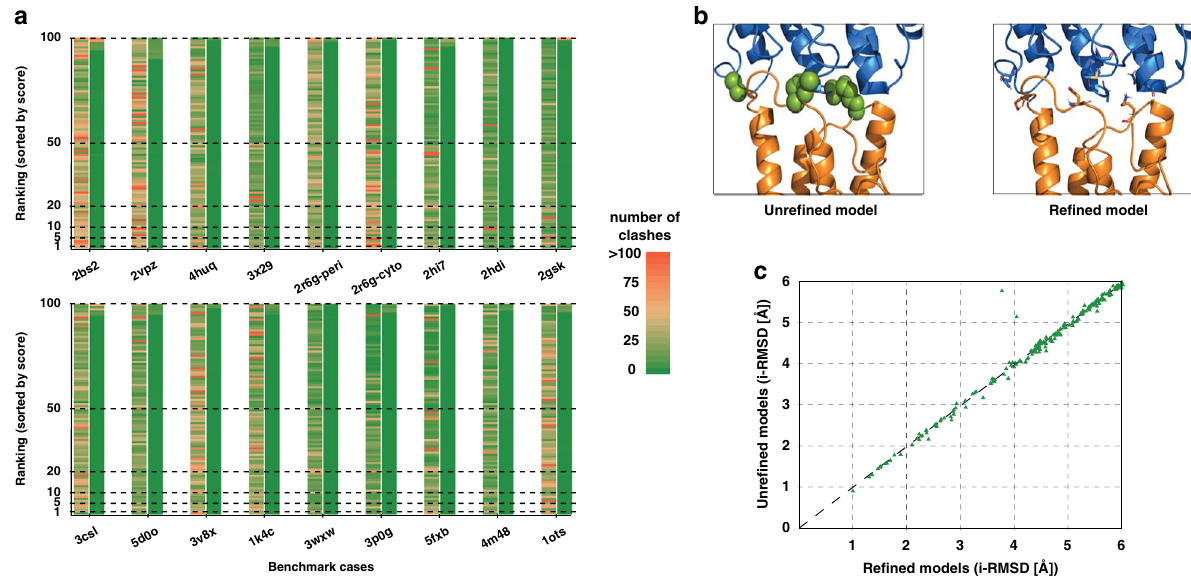
Fig. 5 Analysis of the quality of the membrane-associated protein models before and after re fi nement with HADDOCK. a Stacked bar plot of the top 100 generated models for each of the benchmark cases (18 in total) ranked by their respective score (left – LightDock DFIRE docking score, right-HADDOCK score). For each complex the left bar corresponds to the unre fi ned models and the right bar to the re fi ned models. The color coding (from green to red) indicates the number of clashes. b Illustration of a complex before and after re fi nement. Green spheres represent atomic clashes. The corresponding side chains are shown as sticks in the re fi ned model. c i-RMSD comparison of all models with an i-RMSD ≤ 6 Å before and after re fi nement (183 in total). Points above the diagonal indicate an improvement in i-RMSD value. Source data are provided as an excel fi